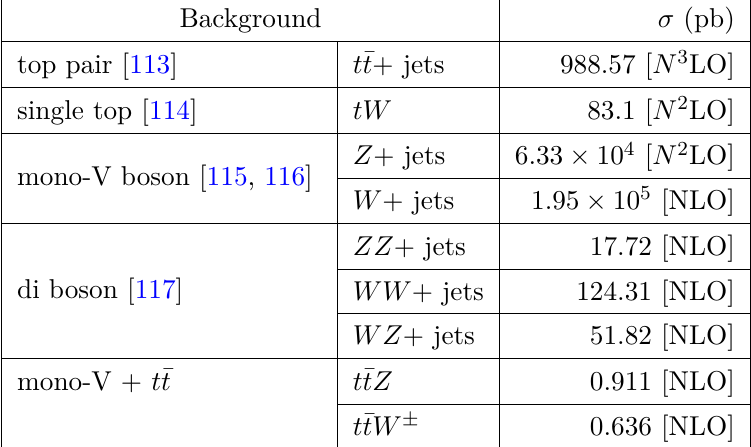
Table 3. Higher-order QCD corrected cross-section at the 14 TeV LHC of different background processes considered in our study. The order of QCD correction is given in brackets. For the final process, higher-order QCD corrected cross-section in five massless quark flavors at 14 TeV LHC obtained from MG5_aMC@NLO . Default factorization and renormalization scales and an in-built NN23NLO pdf set are